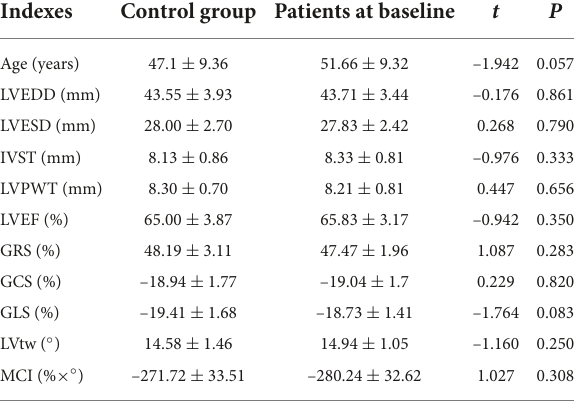
Table 2 indicated that the patients in chemotherapy group showed no significant differences in LVEDD, LVESD, IVST, LVPWT, LVEF and GRS among different chemotherapy stages higher than that at baseline, the GLS and MCI in the interim TABLE 1 Comparison of various indexes between the control group and the patients at baseline ( ¯ x ±